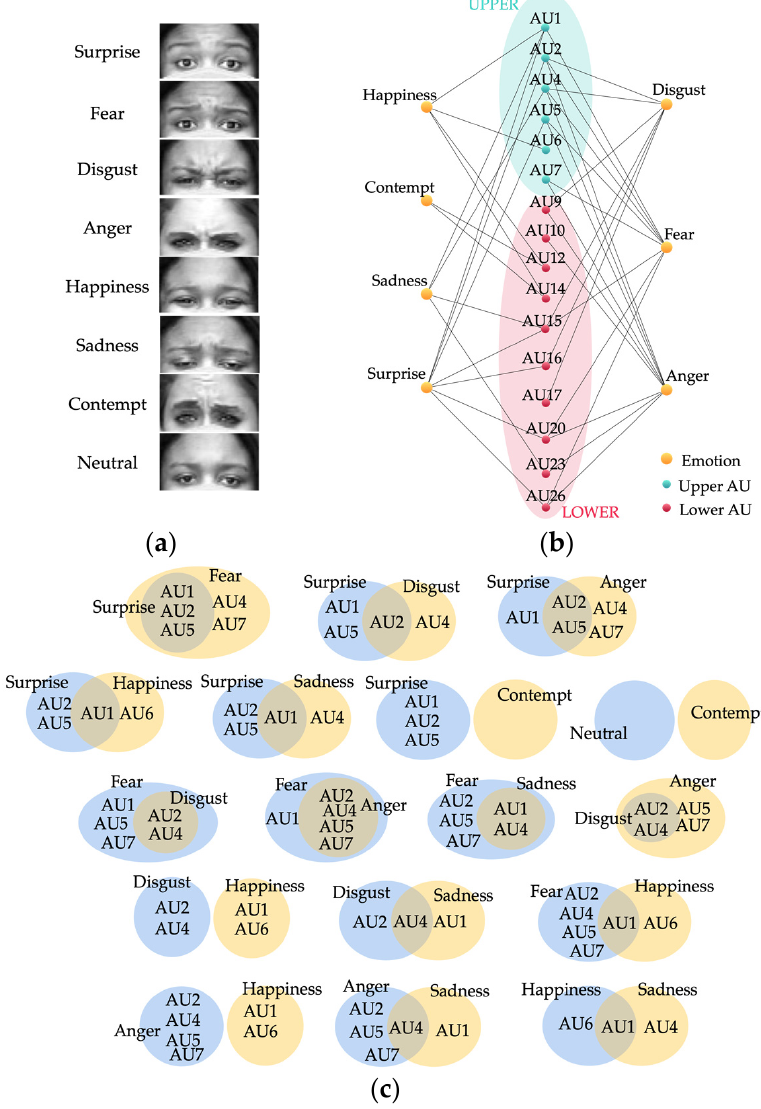
Figure 1. Upper portion of the face and AU samples of the baseline emotions; ( a ) upper face; ( b ) AUs of each emotion; ( c ) comparison of the upper AUs of each pair of emotions.